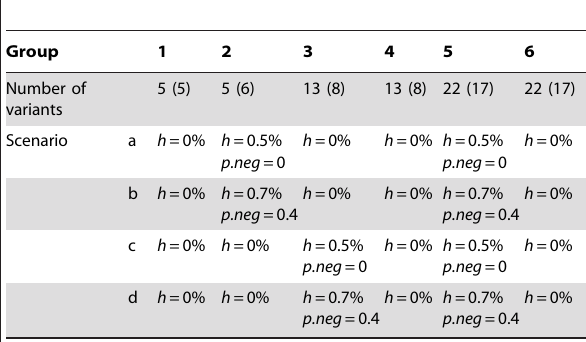
Table 2. Simulations with six